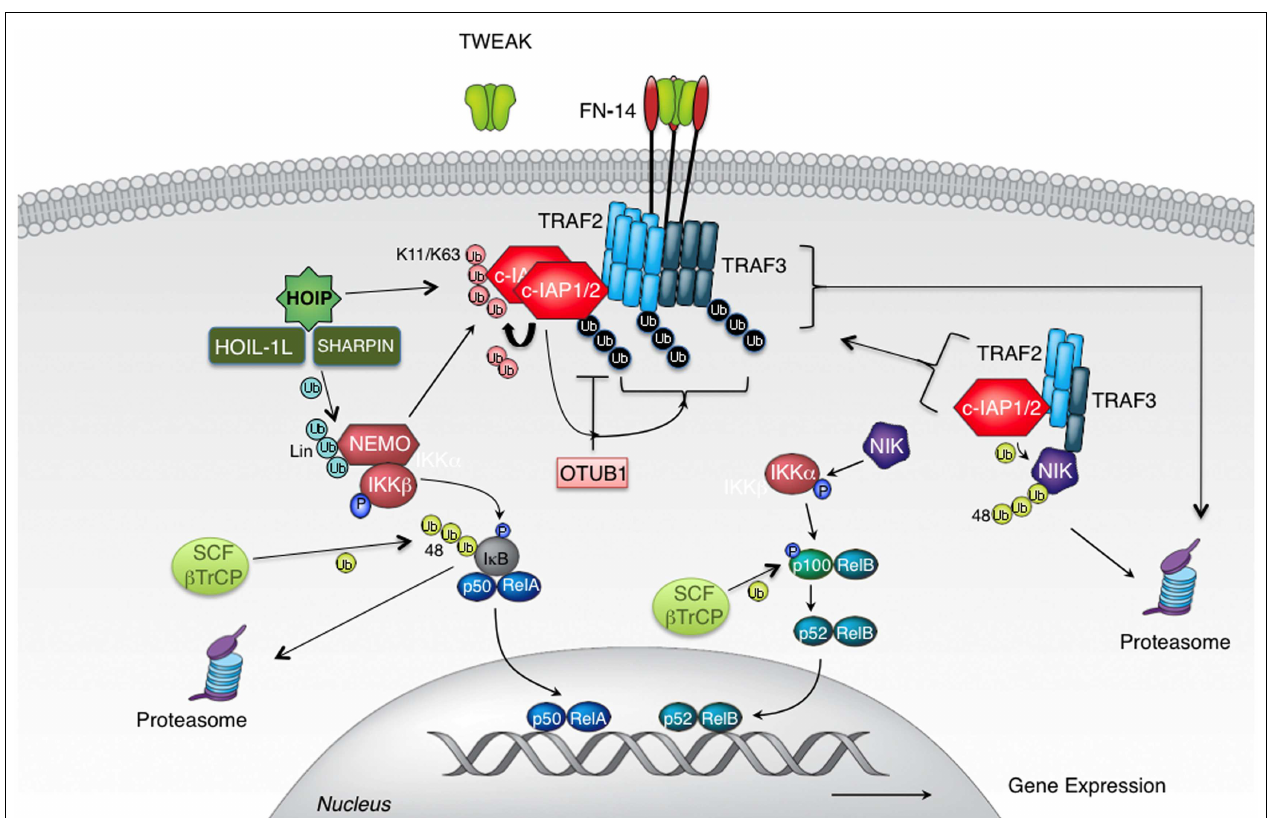
protein/RNF31; Sharpin, SHANK-associated RH domain-interacting protein; IKK, I κ B kinase; NEMO, NF- κ B essential modulator; NIK, NF- κ B inducing kinase; SCF-bTrCP, Skp1/Cul1/F-box β transducin repeat-containing protein; TRAF, tumor necrosis factor (TNF) receptor-associated factor;TWEAK, TNF-related weak inducer of apoptosis; Ub,